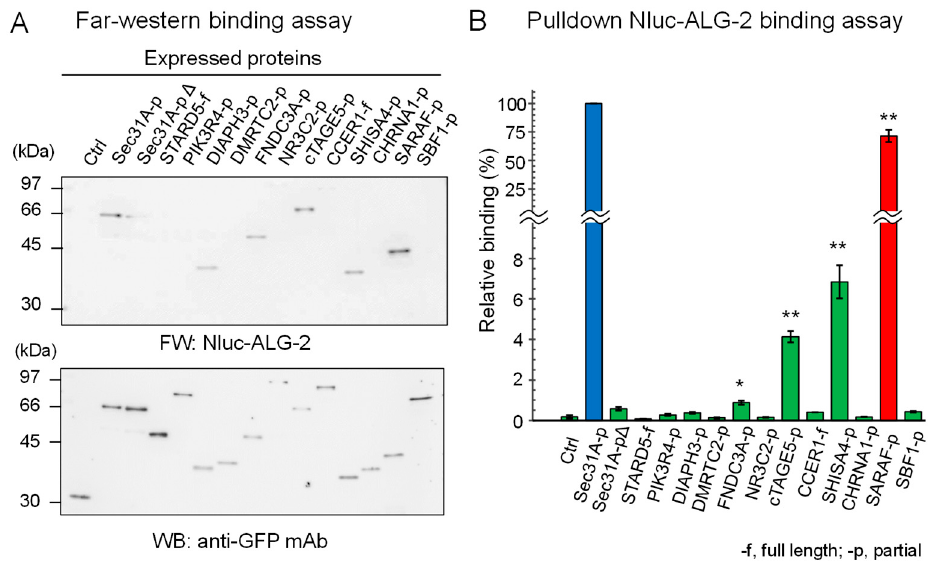
Figure 1. ALG-2-binding assays of SGFP2-fused proteins containing ABM-2 sequences. Full lengths (-f) or partial fragments (-p) of ALG-2-binding candidate proteins that were fused with SGFP2 or unfused negative control SGFP2 (Ctrl) were transiently expressed in HEK293 ALG-2KD cells. After SGFP2-fused proteins had been immunoprecipitated with anti-GFP pAb from cleared cell lysates as described in Materials and Methods, proteins bound to the protein G-immobilized magnetic beads were subjected to ALG-2-binding assays by ( A ) Far Western blotting (FW) and by ( B ) pulldown assays. ( A ) Blotted membranes were probed with Nluc-ALG-2 for FW (upper panel) and anti-GFP mAb (lower panel) for Western blotting (WB). ( B ) The amounts of Nluc-ALG-2 bound to the beads were quantified by measuring luciferase activities. Binding activities relative to Sec31A-p (100%) were calculated and data were expressed as mean ± SE ( n = 3). Binding capacities compared to the negative control were statistically evaluated: * p < 0.01; ** p < 0.001.